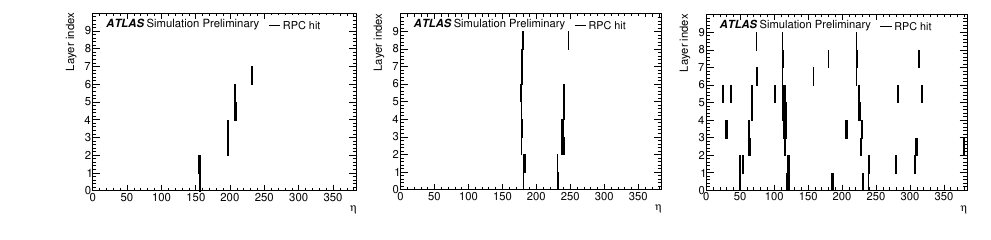
Figure4:AnexampleinputtoaConvolutionalNeuralNetwork(CNN)forthePhase-2ATLASLevel-0muon trigger,implementedonaFPGA,isshownfora12GeVand15GeVmuonswithoutbackground.ResistivePlate Figure7:AnexampleinputtoaConvolutionalNeuralNetwork(CNN)forthePhase-2ATLASLevel-0muon trigger,implementedonaFPGA,isshown.Thisexamplecontainsthreemuonswithbackground.ResistivePlate Figure3:AnexampleinputtoaConvolutionalNeuralNetwork(CNN)forthePhase-2ATLASLevel-0muontrigger, implementedonaFPGA,isshownfora4GeVmuonwithoutbackground.ResistivePlateChambers(RPC)hits Chambers(RPC)hitsofafixed  sectorarearrangedinamatrix-likeobject.Eachbinofthe y -axiscorrespondstoa detectorlayer(3detectorlayersforinnerstation,4forthemiddleand2fortheouterstation).The x -axismapsthe ⌘ Chambers(RPC)hitsofafixed  sectorarearrangedinamatrix-likeobject.Eachbinofthe y -axiscorrespondstoa detectorlayer(3detectorlayersforinnerstation,4forthemiddleand2fortheouterstation).The x -axismapsthe ⌘ ofafixed  sectorarearrangedinamatrix-likeobject.Eachbinofthe y -axiscorrespondstoadetectorlayer(3 detectorlayersforinnerstation,4forthemiddleand2fortheouterstation).The x -axismapsthe ⌘ coordinatesof coordinatesofeachphysicsRPCstrip:forthe i -thstrip ⌘ ibin = 384 ⌘ i  ⌘ min ⌘ max  ⌘ min ,where ⌘ max and ⌘ min arerespectively coordinatesofeachphysicsRPCstrip:forthe i -thstrip ⌘ ibin = 384 ⌘ i  ⌘ min ⌘ max  ⌘ min ,where ⌘ max and ⌘ min arerespectively eachphysicsRPCstrip:forthe i -thstrip ⌘ ibin = 384 ⌘ i  ⌘ min ⌘ max  ⌘ min ,where ⌘ max and ⌘ min arerespectivelythemaximum Figure 3. Examples of RPC event images used to train the CNN [11]: (left) an event with one low- p T themaximum( ⌘ max = 0 . 95)andtheminimum( ⌘ min = 0 . 07) ⌘ valuesforthebarrelRPCstripschosentoprevent muonstofalloutsideanylayerofaspecifiedsector;384isarealisticnumberofstripsperlayer.Thisparticular themaximum( ⌘ max = 0 . 95)andtheminimum( ⌘ min = 0 . 07) ⌘ valuesforthebarrelRPCstripschosentoprevent muonstofalloutsideanylayerofaspecifiedsector;384isarealisticnumberofstripsperlayer.Thisparticular ( ⌘ max = 0 . 95)andtheminimum( ⌘ min = 0 . 07) ⌘ valuesforthebarrelRPCstripschosentopreventmuonstofall outsideanylayerofaspecifiedsector;384isarealisticnumberofstripsperlayer. Thisparticularchoicehas choicehasbeentakeninordertoevaluateMLalgorithmperformances,withoutanygeometricalacceptanceeect. Randombackgroundhasbeenadded.Thebackgroundratehasbeenevaluatedfromminimumbiasevents.Events choicehasbeentakeninordertoevaluateMLalgorithmperformances,withoutanygeometricalacceptanceeect. Randombackgroundhasbeenadded.Thebackgroundratehasbeenevaluatedfromminimumbiasevents.Events beentakeninordertoevaluateMLalgorithmperformances,withoutanygeometricalacceptanceeect.Random backgroundhasbeenadded.Thebackgroundratehasbeenevaluatedfromminimumbiasevents.Eventsusedinthe muon ( p T = 4 GeV); (center) an event with two high- p T muons (15 and 12 GeV respectively); (right) usedinthetrainingphaseoftheCNNcanalsocontaintwoormoremuonsinthesamesector.Eventswithmorethan onemuonarebuiltsuperimposingonemuonimageswithnobackground,whichisthenincluded.TheCNNoutputis usedinthetrainingphaseoftheCNNcanalsocontaintwoormoremuonsinthesamesector.Eventswithmorethan onemuonarebuiltsuperimposingonemuonimageswithnobackground,whichisthenincluded.TheCNNoutputis trainingphaseoftheCNNcanalsocontaintwoormoremuonsinthesamesector.Eventswithmorethanonemuon arebuiltsuperimposingonemuonimageswithnobackground,whichisthenincluded.TheCNNoutputissetto an event with three muons and background noise due to pileup and cavern settoevaluatetransversemomentumand ⌘ oftheleadingandsub-leadingmuons(ifthelatterexists)inthesector andreturnsalsoaflagforeventsthatcontainmorethan2muons. settoevaluatetransversemomentumand ⌘ oftheleadingandsub-leadingmuons(ifthelatterexists)inthesector andreturnsalsoaflagforeventsthatcontainmorethan2muons. evaluatetransversemomentumand ⌘ oftheleadingandsub-leadingmuons(ifthelatterexists)inthesectorand returnsalsoaflagforeventsthatcontainmorethan2muons.